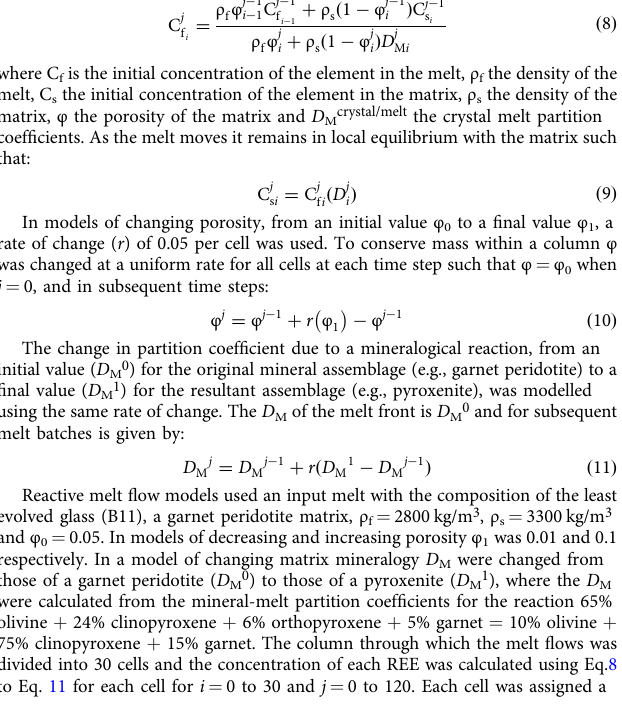
Fig. 1f and λ 1 = 16.34 in Fig. 1j), and λ 2 the curvature of the REE pattern (i.e., the openness or tightness and upward or downward opening of the quadratic